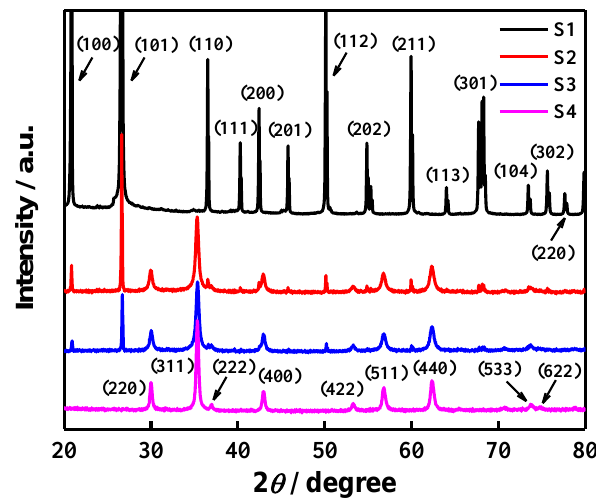
Figure 1. X-ray diffraction patterns of S1, S2, S3, and S4 samples. Figure 1. X-ray di ff raction patterns of S1, S2, S3, and S4